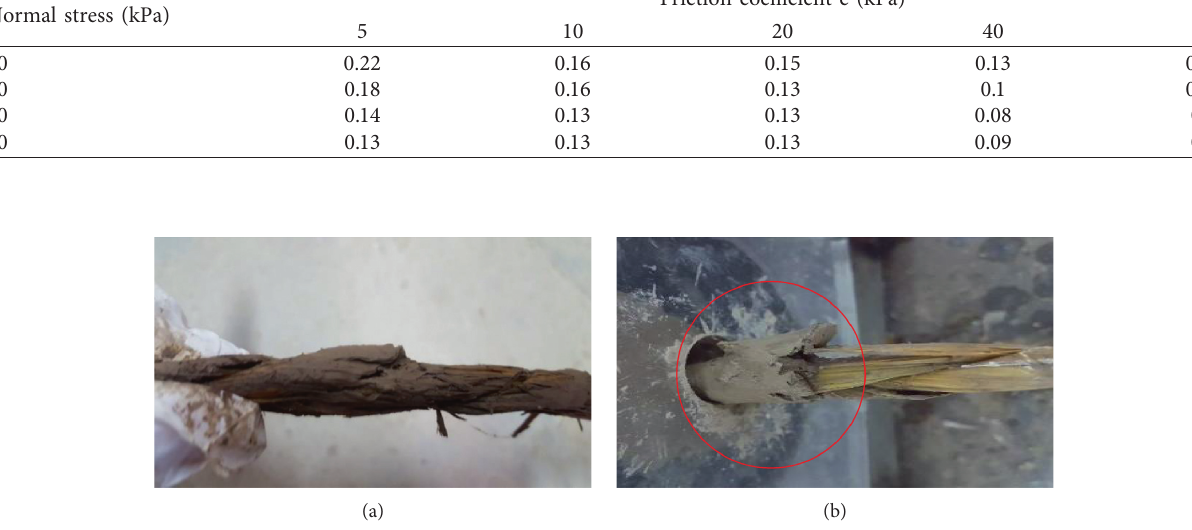
Figure 6: The appearance of sample before and after pull-out test. (a) Before test and (b) after test.